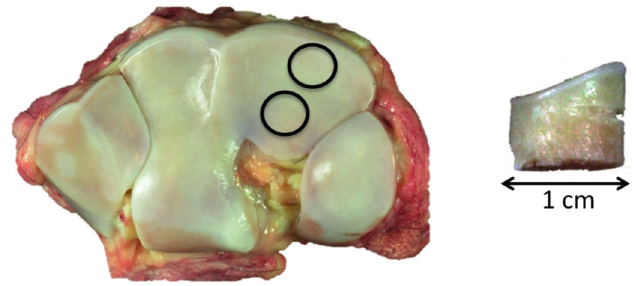
Figure 7. Left , control, showing the 1-cm core sample location, dorsal top; and right , core sample with dorsal